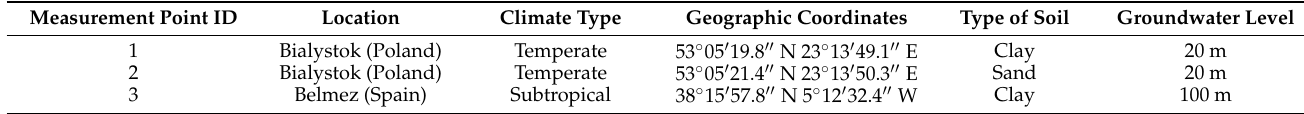
Table 1. Description of the location of measurement points.